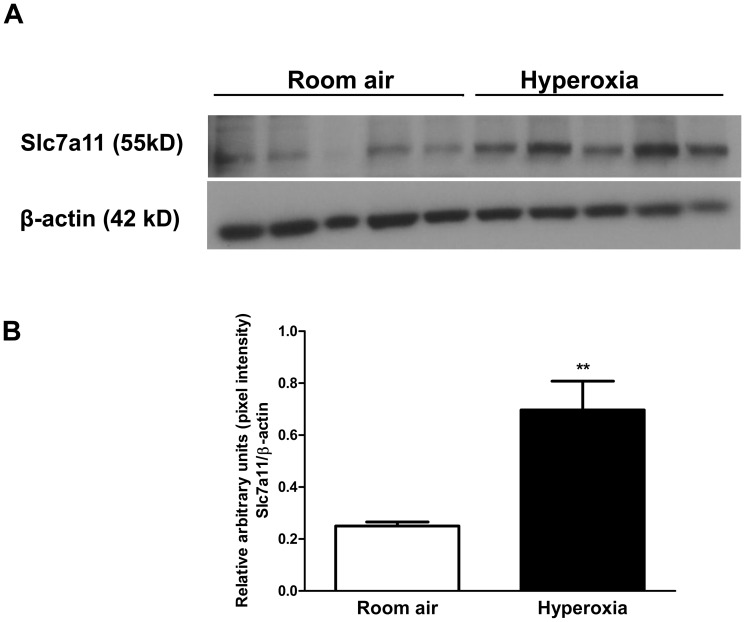
Increased Slc7a11 expression in the lungs (male) following hyperoxia exposure.
8A: Western blot assay for Slc7a11 expression in lungs following hyperoxia exposure. Twenty µg of whole lung protein from male animals at room air and exposed to 48 h of hyperoxia was subjected to western blotting using antibodies against Slc7a11. Under each sample lane is the corresponding β-actin blot to assess for protein loading. 8B: Densitometry analysis of pulmonary Slc7a11 immunoblots at room air and after 48 h of hyperoxia exposure. Significant differences from room air controls are indicated by **, p<0.01.